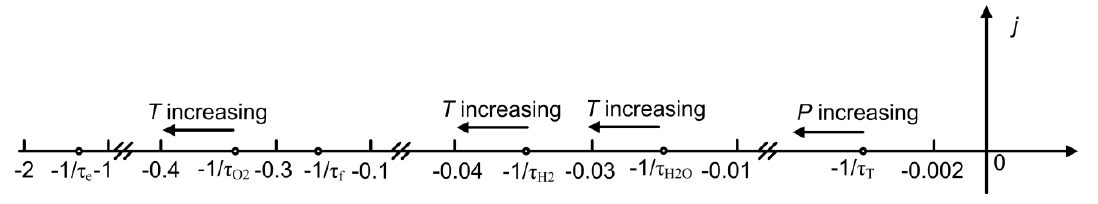
Figure 3. Illustrative of the positions of the six poles of the dynamic